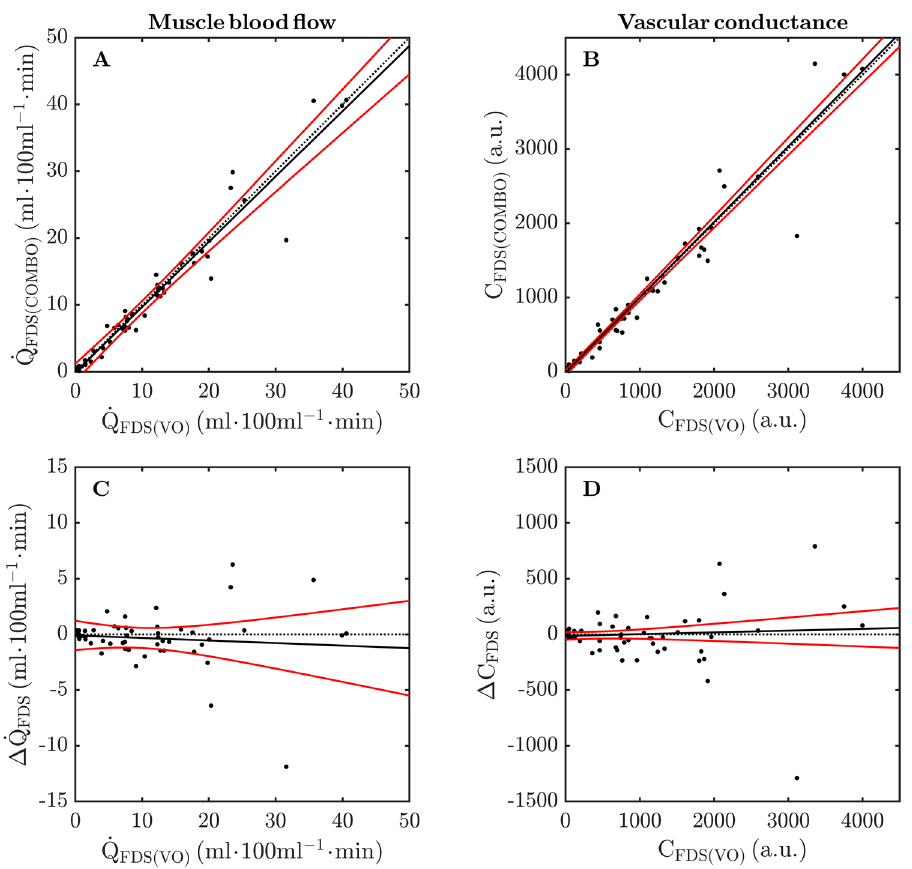
Figure 4. Measurement agreement between venous and combined occlusion trials for muscle blood flow ( A , C ) and vascular conductance ( B , D ) of the flexor digitorum muscle (FDS) during isometric handgrip exercise. Solid points represent individual data points from all participants at rest, and immediately following isometric handgrip exercise at 20, 40 and 60% of maximal voluntary contraction. The dotted lines denote the line-of- identity (i.e., perfect agreement). The solid lines represent the predicted group-level response obtained via robust linear mixed effects modeling. The solid red lines represent simultaneous 95% confidence intervals of the predicted group-level response. VO: venous occlusion; COMBO: combined venous and arterial occlusion; (cid:31) ˙ Q and (cid:31) C : differences in muscle blood flow and vascular conductance between VO and COMBO trials, respectively (i.e.,